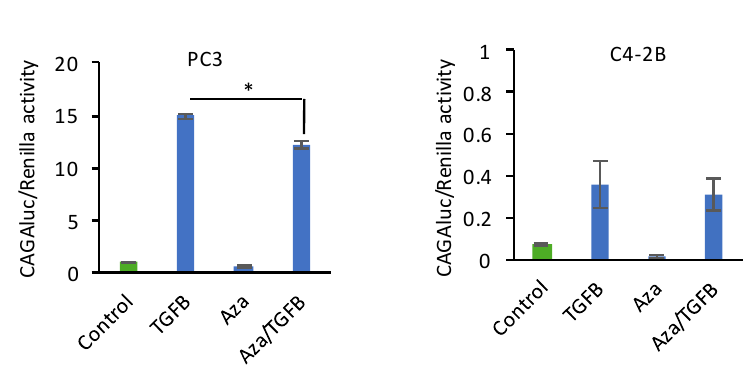
Figure 1. Decitabine treatment of PC3 cells increases DKK3 expression and inhibits TGF- β -dependent gene reporter activity. ( A ) Combined bisulfite restriction analysis (CoBRA) of DKK3 gene promoter methylation in PC3 cells after treatment with decitabine (2 µ M, 3 days); gel shows undigested (U) and BstUI-digested (D) PCR products, * promoter de-methylation. ( B ) Q-RT-PCR analysis of DKK3 mRNA levels in untreated and 5-aza-2′deoxycytidine (5-aza-dC)-treated PC3 and C4-2B cells; * p < 0.05, 2-tailed Student’s t -test versus untreated. ( C ) TGF-β-dependent gene reporter activity (luciferase/renilla), relative to control, in PC3 and C4-2B cells transfected with CAGA12-luciferase and renilla and either untreated (control) or treated with decitabine (Aza) and/or TGF-β for 24 h. Data are shown as means ± SEM ( n = 3). * p < 0.05, ANOVA and two-tailed Student’s t -test.